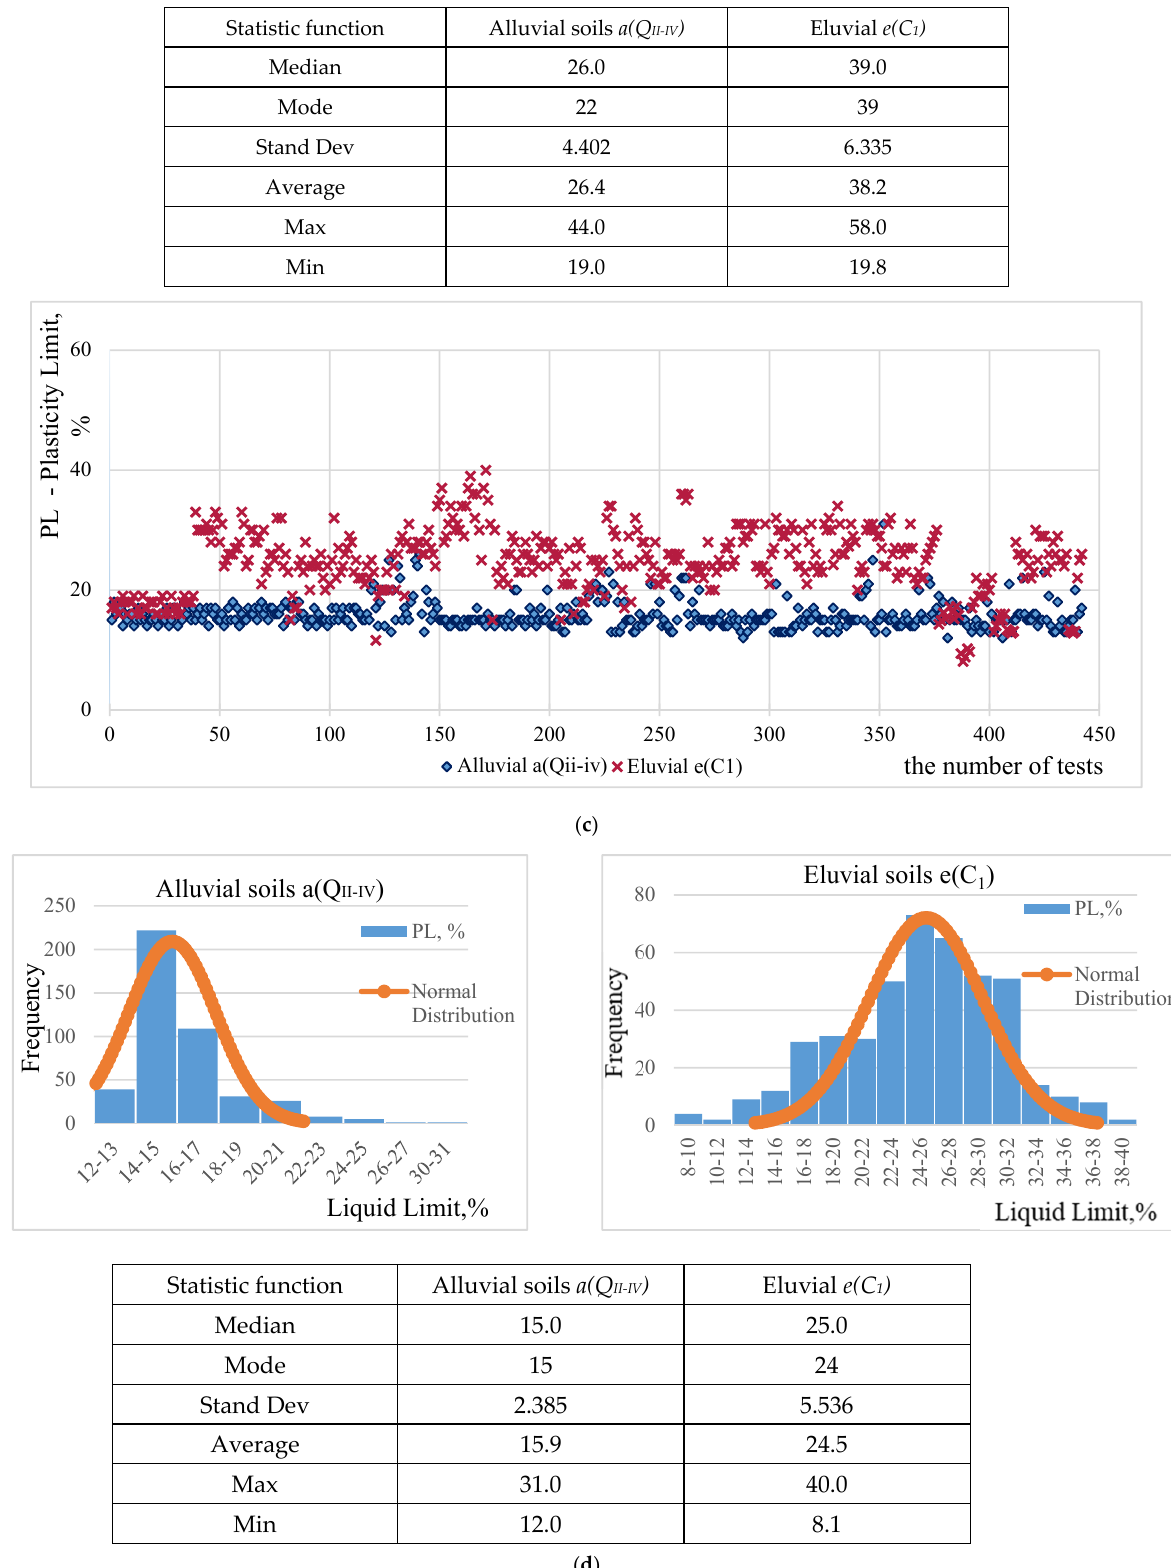
Figure 3. Scatter plot of the Liquid ( a ) and Plastic ( c ) Limits for alluvial and eluvial clay soils, normal distribution for the Liquid ( b ) and Plastic ( d ) Limits data and their statistical